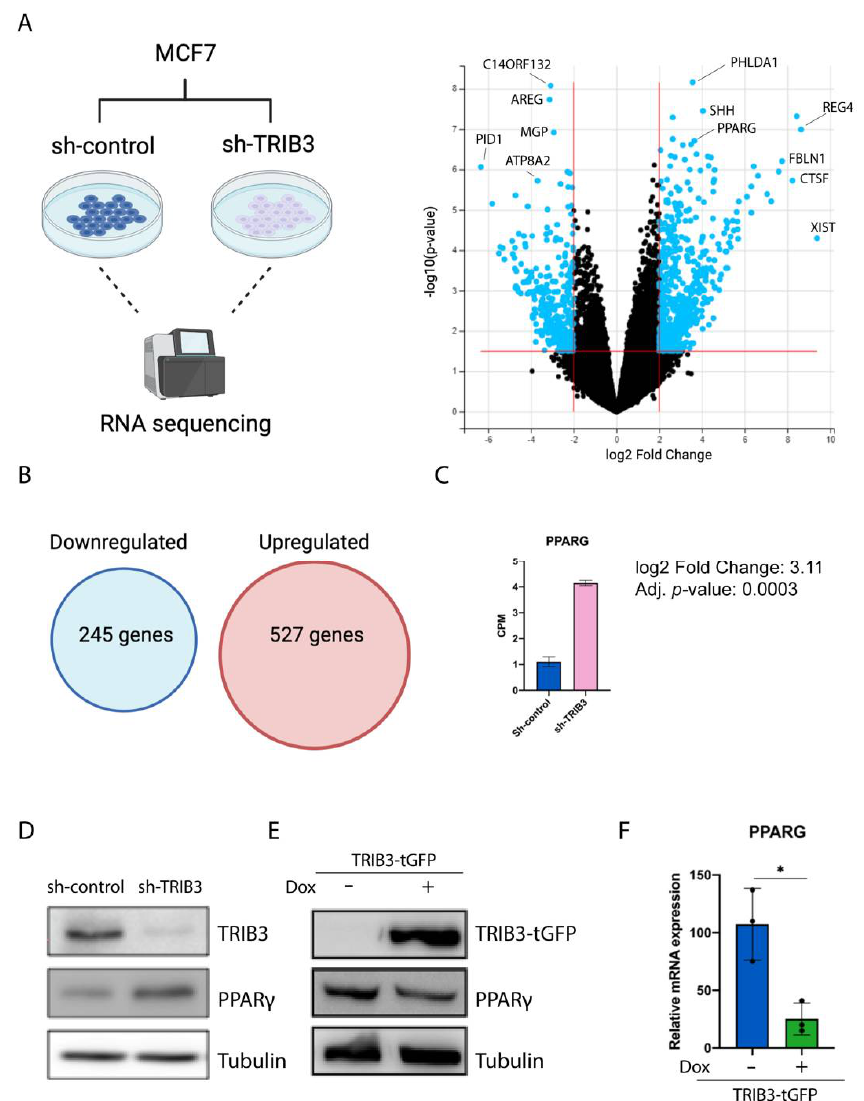
Figure 1. TRIB3 regulates PPAR γ expression in MCF7 cells. ( A ) Schematic representation of the RNA-seq experiment and volcano plot showing differentially expressed genes between Sh-TRIB3 and Sh-control cells. ( B ) Up- and downregulated genes ( p -adjusted value > 0.05). ( C ) Counts per million of PPARG in Sh-control and Sh-TRIB3 cells. ( D ) Western blot of endogenous TRIB3 expression and PPARG in Sh-control and Sh-TRIB3 in MCF7 cells and Tubulin as loading control. ( E ) Western blot of TRIB3-tGFP using anti-tGFP antibody and endogenous PPARG in inducible TRIB3-tGFP MCF7 cells. ( F ) Relative mRNA expression of PPARG in inducible TRIB3-tGFP MCF7 cells treated with and without doxycycline. * p <